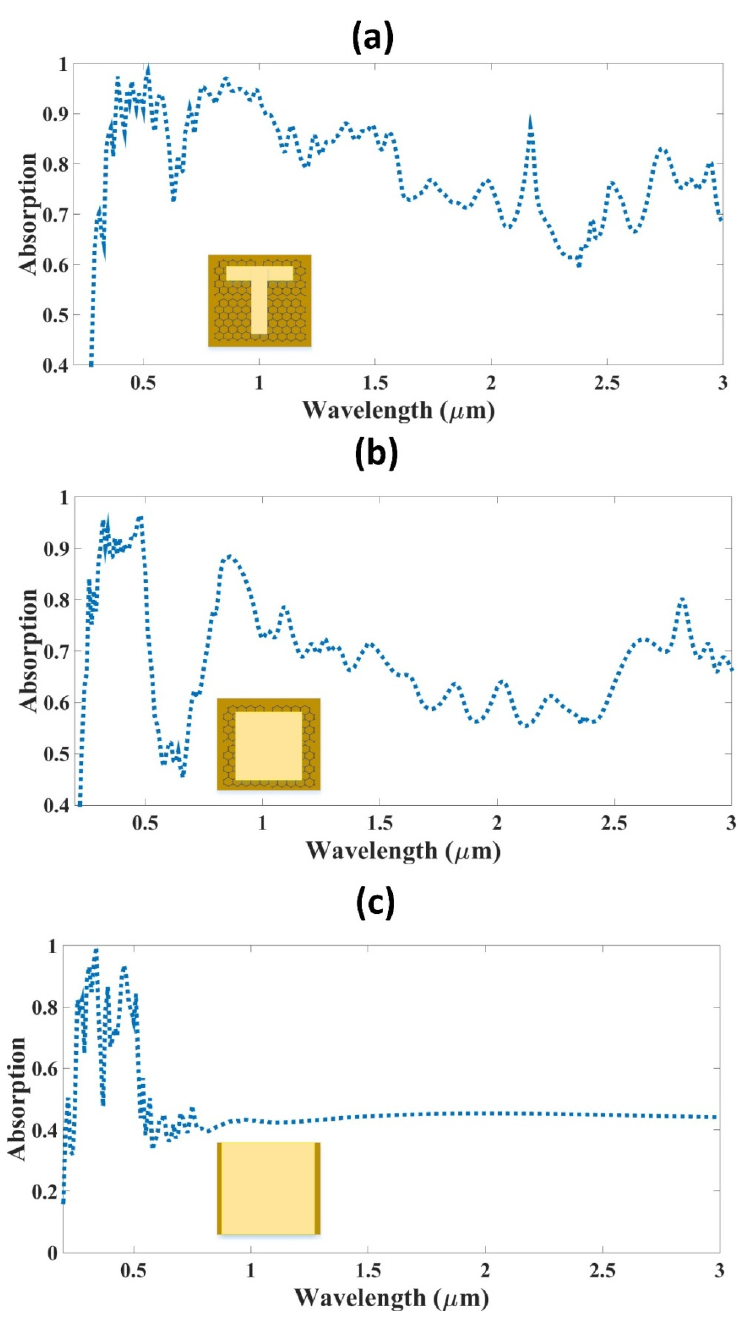
Figure 2. Absorption results for different metasurface solar absorbers. ( a ) T-shape metasurface design. ( b ) Square-1 metasurface shape design. ( c ) Square-2 metasurface shape design.